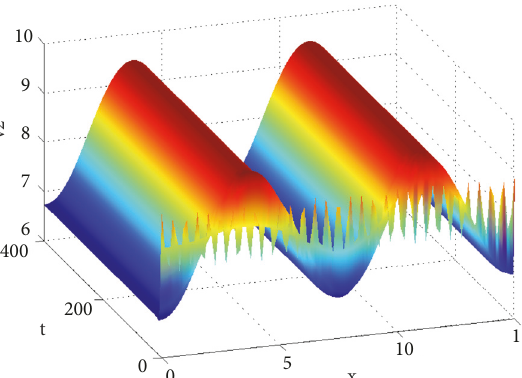
Figure 1: Dynamic behavior of solution 𝑢 1 .